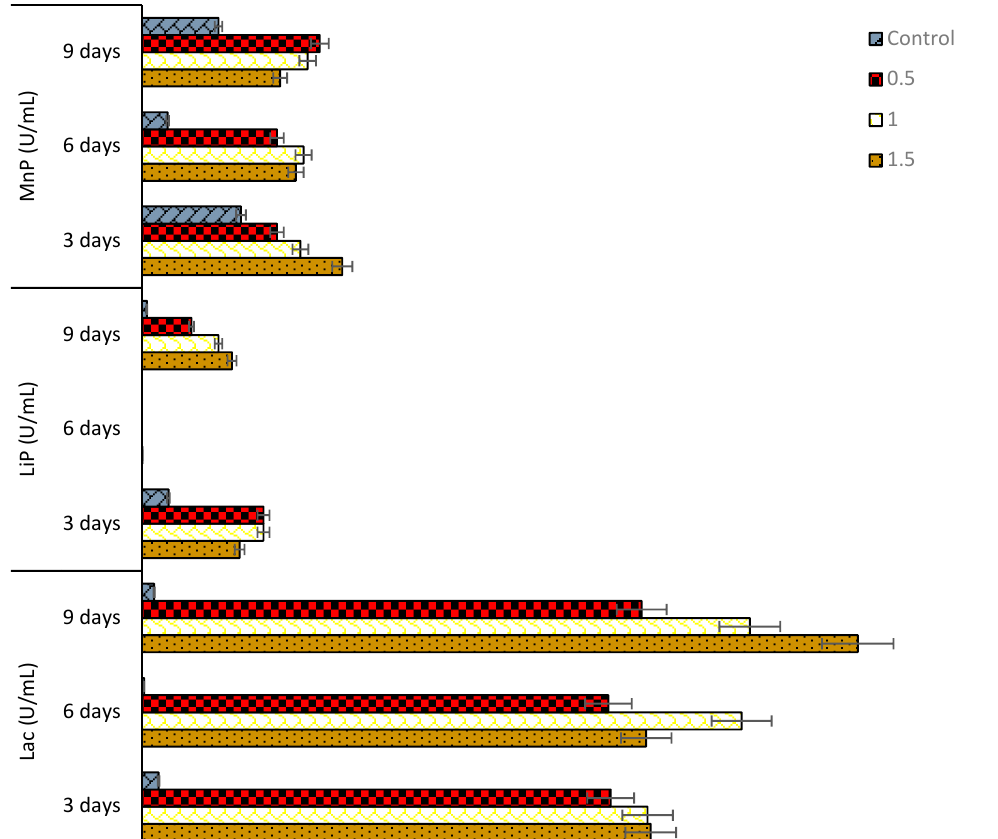
Figure 3. Plate assay for colorimetric screening of ligninolytic enzymes produced by the isolated fungi. ( i ) Control— Mucor irregularis strain B-Yorla10 growing on MEA without chemicals ( ii ) Mucor irregularis strain B-Yorla10 showing reddish brown coloration on reaction with MEA supplemented with CuSO4 and Guaiacol ( iii ) Mucor irregularis strain B-Yorla10 showing reddish brown coloration on reaction with MEA supplemented with CuSO4 and ABTS ( iv ) Control— Aspergillus oryzae strain C-E ff urun growing on MEA without chemicals ( v ) Aspergillus oryzae strain C-E ff urun showing reddish brown coloration on reaction with MEA supplemented with CuSO4 and Guaiacol ( vi ) Aspergillus oryzae strain C-E ff urun showing reddish brown coloration on reaction with MEA supplemented with CuSO4 and ABTS.